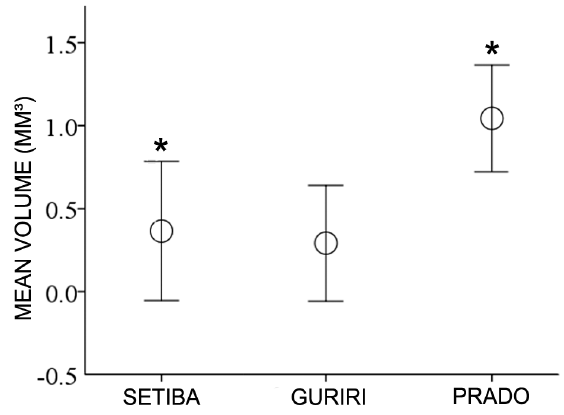
Figure 2 - Mean volume (log-transformed) of the three largest prey items ingested per stomach of Phyllodytes luteolus in three remnants restinga along the eastern coast of Brazil (Setiba, Guriri and Prado). The asterisk means that the volume of prey consumed was signi fi cantly different between these populations. Sample sizes: Setiba = 47, Guriri = 22 and Prado = 55.